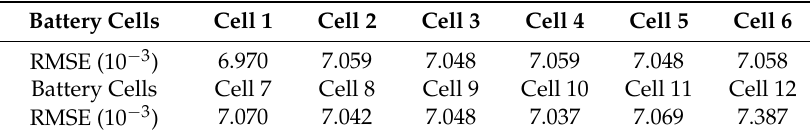
Table 6. RMSE for SOC estimated in different